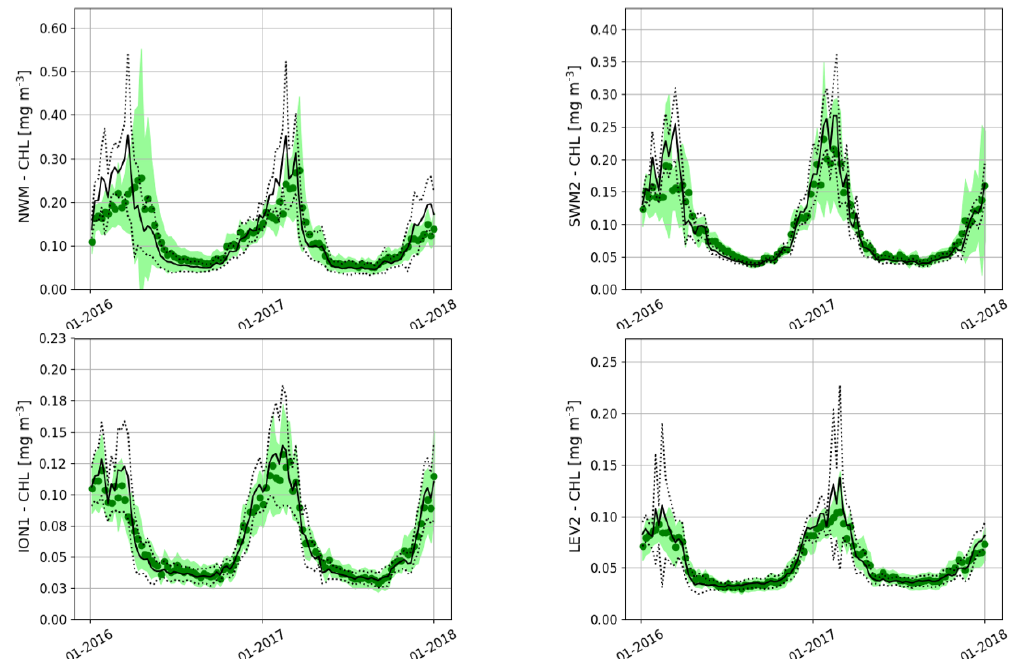
Figure 4. Model (black line, with standard deviation in black dots) and satellite (green dots, with standard deviation covering the light-green area) time series of mean surface chlorophyll concentration in open sea areas in four selected sub-basins of Fig.